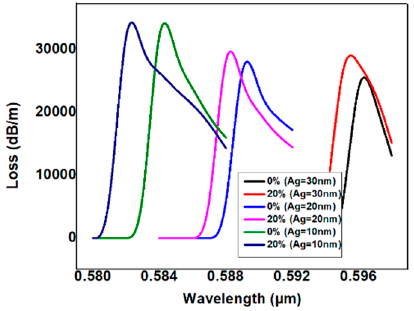
Figure 4. Variation of loss spectral shift for the bimetallic thickness of Ag = 30 nm, 20 nm, 10 nm under the constant thickness of Cu = 10 nm.